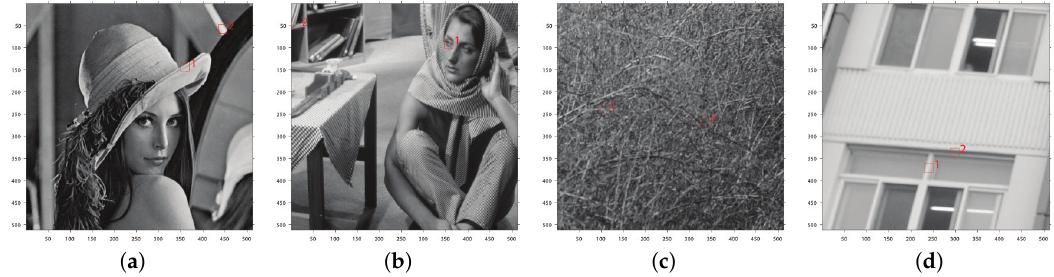
Figure 8. Natural 512 × 512 pixel images: ( a ) Lena; ( b ) Barbara; ( c ) Shrub; and ( d )